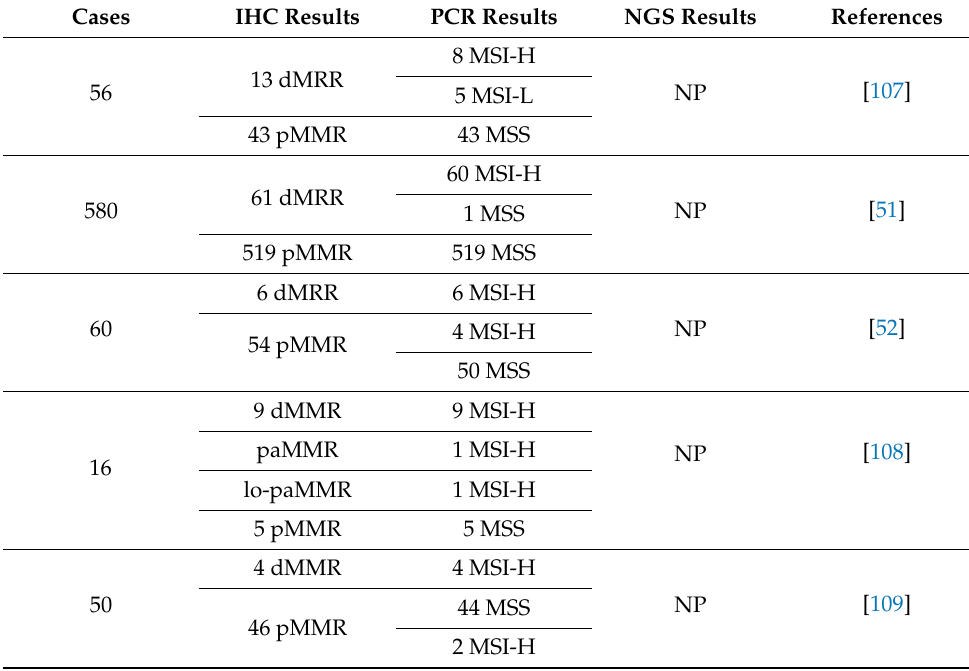
Table 4. Comparison between IHC, PCR and NGS in GC